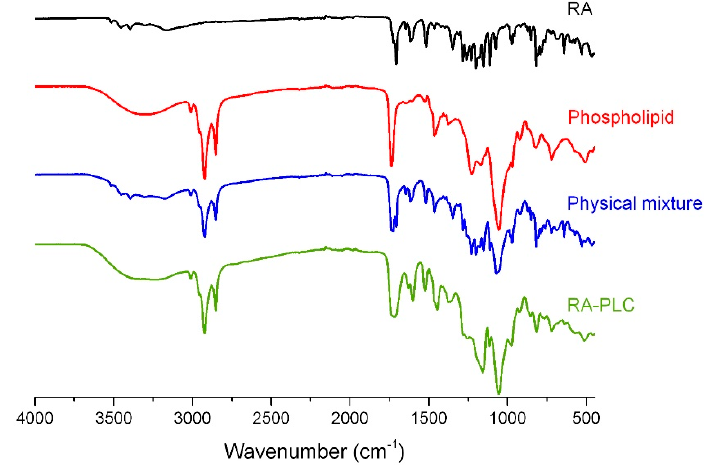
Figure 3. IR spectra of RA, phospholipid, physical mixture, and RA-PLC.